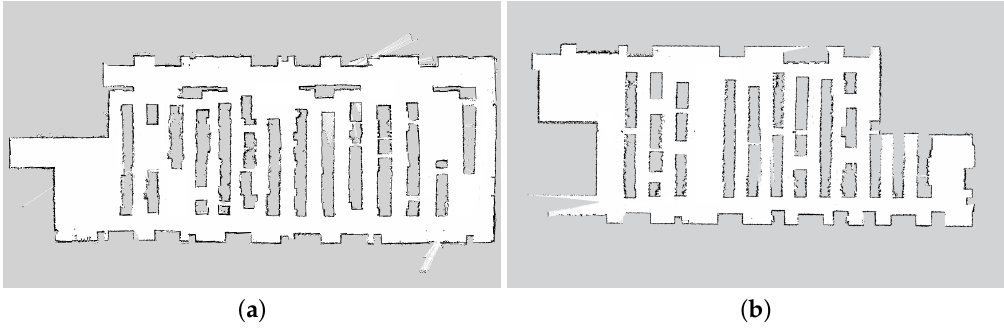
Figure 8. The two maps created with the mapping procedure. Due to the non-disclosure agreement, the map shown in these pictures has been partially edited in order to not reveal the real planimetry of the room. ( a ) Room 1; ( b ) Room